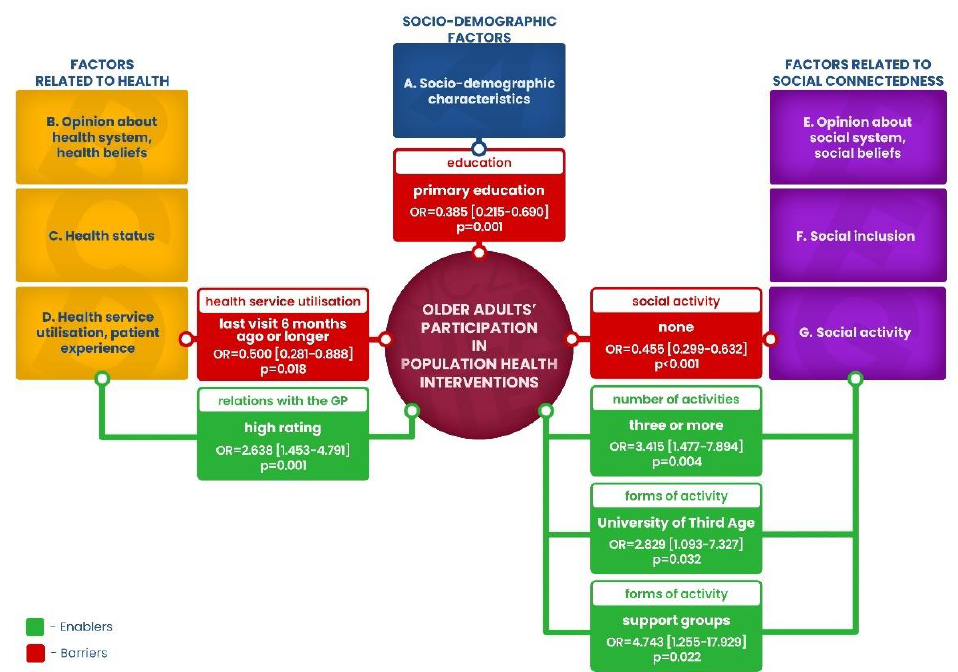
Figure 6. Barriers and enablers of participation for older people in health programmes.